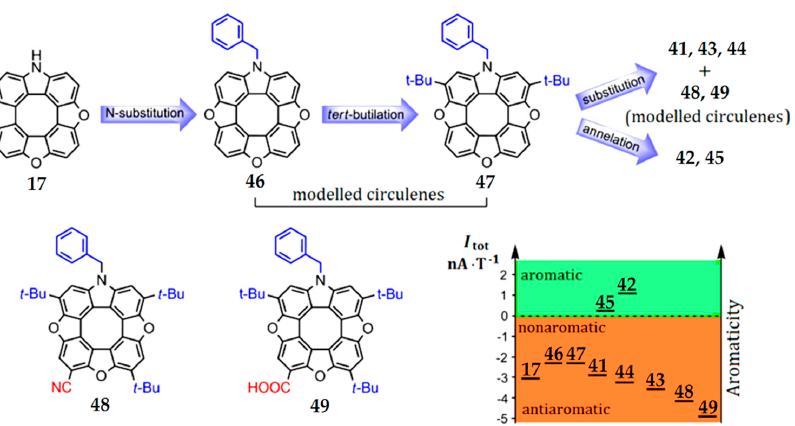
Figure 13. Logical scheme for subsequent functionalization of the simplest hypothetical azatri- oxa[8]circulene 17 vs. changing diagram for the net magnetically induced ring current strengths [93].